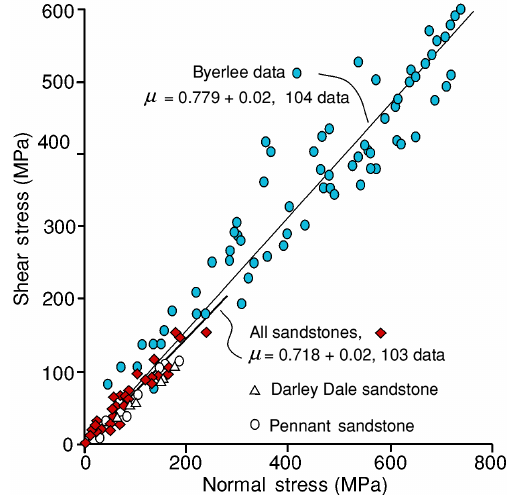
Figure 1. Compilation of friction data for (mainly crystalline) rocks up to a normal stress of 800MPa by Byerlee (1978). In this pressure range there is no basis for recognizing two pressure regimes rep- resented by different friction coefficients. Data are also shown for various other sandstones, from Rutter (for Berea sandstone, unpub- lished), Menéndez et al. (1996), Mair and Marone (1999), Numelin et al. (2007) and Scott and Nielsen (1991a, b), plus Pennant and Darley Dale sandstones (this study). Collectively, the sandstones display a slightly lower friction coefficient (0.718) than the crys- talline rocks